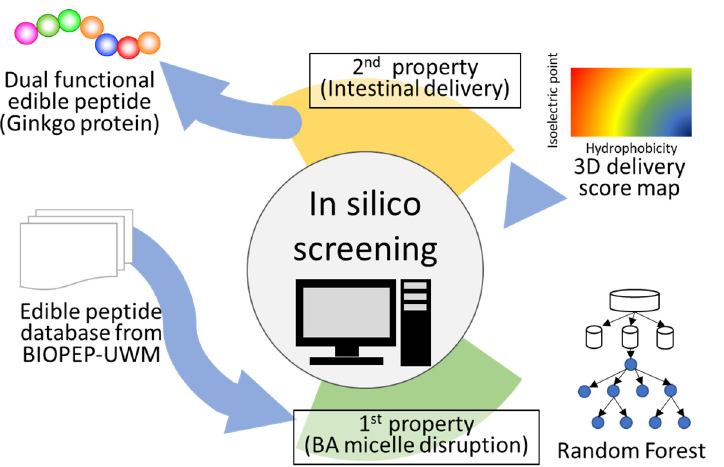
Figure 1. Schematic of the method for peptide screening. A peptide database created from BIOPEP- UWM was used as a peptide library. The peptides stored in the library were adapted to the random forest model. Peptides with scores of >0.5, predicted to be positive, were used for further screening. All candidate peptides were plotted on the color map, and peptides with scores >50 were selected and subjected to in vitro assays. Five peptides were selected using this method.